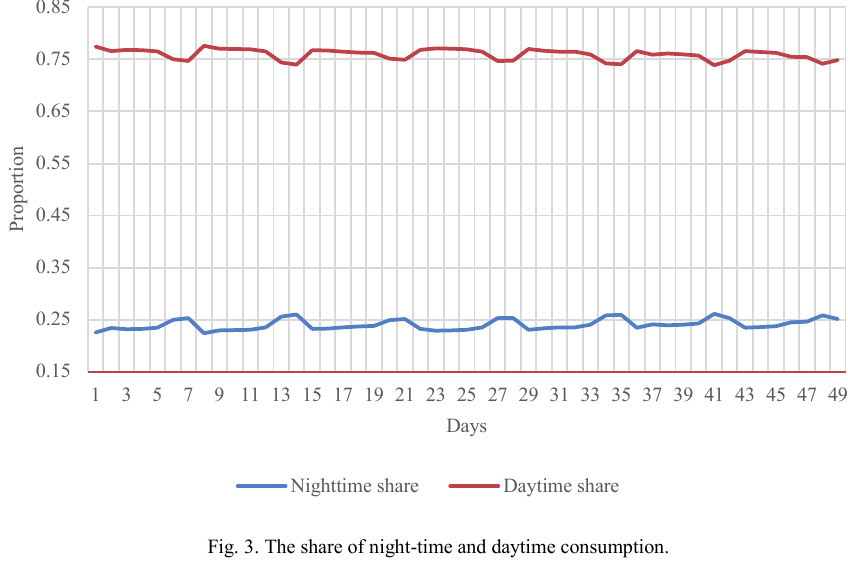
Fig. 3. The share of night-time and daytime consumption.